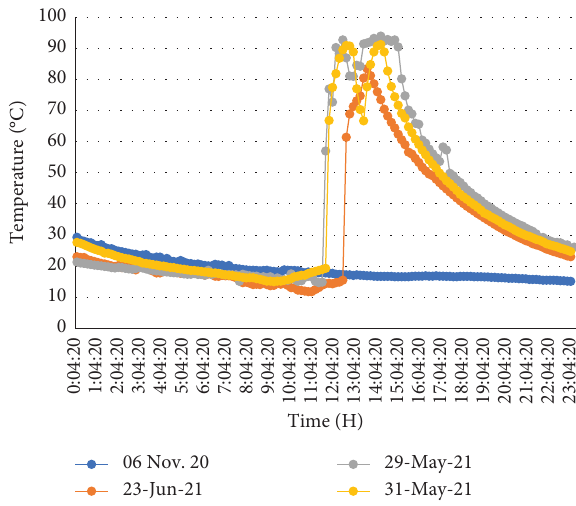
Figure 5: Evaporator SW temperature on various days under low average solar radiation.